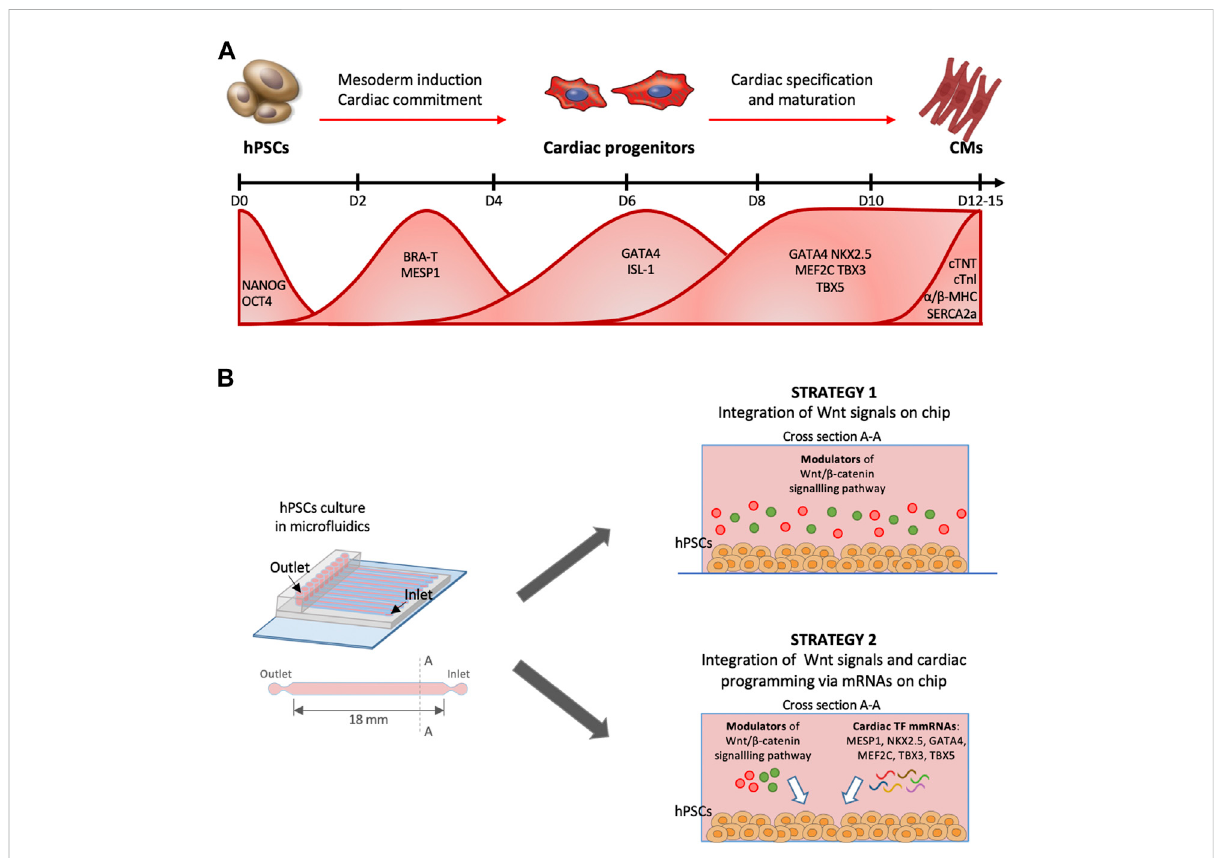
FIGURE 1 Timing of cardiomyocyte differentiation from hPSCs. (A) Timeline of cardiac differentiation steps from pluripotent stem cells. Bottom, waves of expression of the principal cardiac TFs during in vitro cardiac differentiation from pluripotent stem cells. (B) Schematic protocol for hPSCs cardiac programmingimplementingtwostrategiesinmicro fl uidics.FirststrategyprovidestheintegrationofWnt/ β -cateninpathwaymodulation,thesecond one the combination between Wnt/ β -catenin signals and a forced sequential endogenous protein expression via cardiac mmRNA